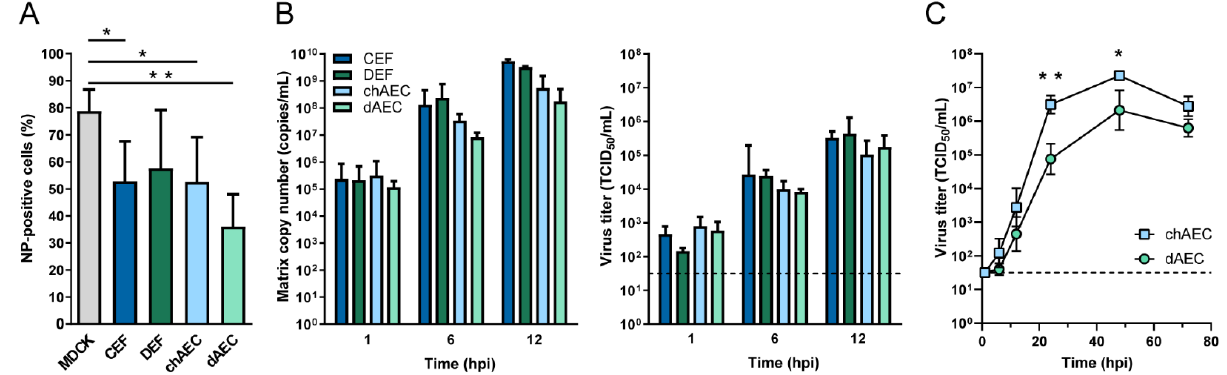
Figure 3. Replication kinetics of H5N1 HPAIV in duck and chicken endothelial cells. ( A ) MDCK, CEF, DEF, chAEC, and dAEC were inoculated with A/Vietnam/1203/04 H5N1 virus isolate at an MOI of 1. Cells were harvested at 6 hpi, and infection percentages were determined by NP staining and flow cytometry. Bars indicate the mean of four biological replicates, and the error bars represent the SD. ( B ) CEF, DEF, chAEC, and dAEC were inoculated as described for panel A, and supernatants were harvested at the indicated time points. Viral copy numbers were quantified by RT-qPCR on the matrix gene segment (left), and infectious virus titers were determined by endpoint titration in MDCK cells and expressed as TCID 50 /mL (right). Bars indicate the mean of three biological replicates, and the error bars represent the SD. Dotted line represents the limit of detection of the endpoint titration assay. ( C ) ChAEC and dAEC were inoculated with A/Vietnam/1203/04 H5N1 virus isolate at an MOI of 0.001. Supernatants were harvested at the indicated time points, and infectious virus titers were determined by endpoint titration in MDCK and expressed as TCID 50 /mL. Data are presented as mean ± SD from three independent experiments. Dotted line represents the limit of detection of the endpoint titration assay. Statistically significant differences were determined by one-way ANOVA followed up with individual unpaired t-tests. * p < 0.05; ** p <